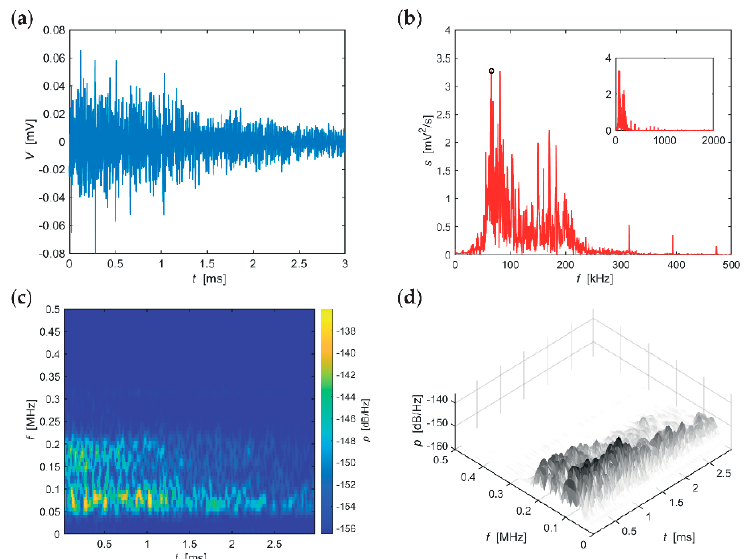
Figure 7. Visualisation of the recorded AE signal during 75-10 F-T cycles from specimens CS100: ( a ) time course of the amplitude, ( b ) frequency spectrum, ( c ) spectrogram STFT-2D image, ( d ) spectrogram STFT-3D image.